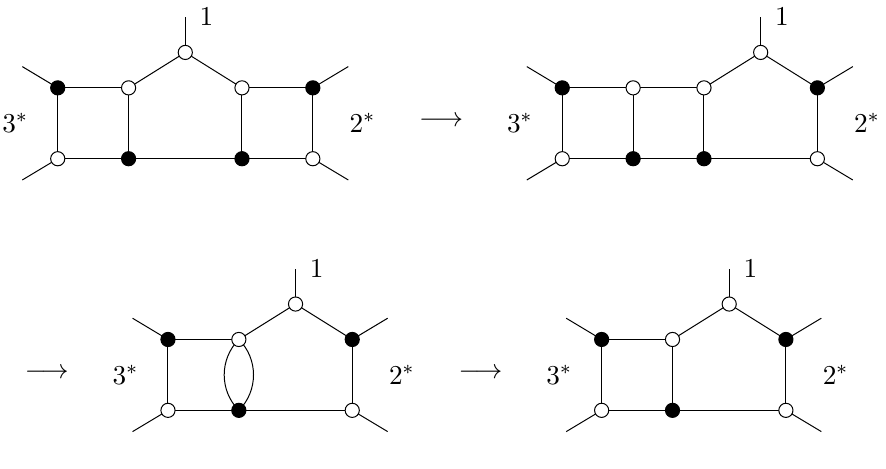
Figure 3 . On-shell diagram transformations for A (cid:3)